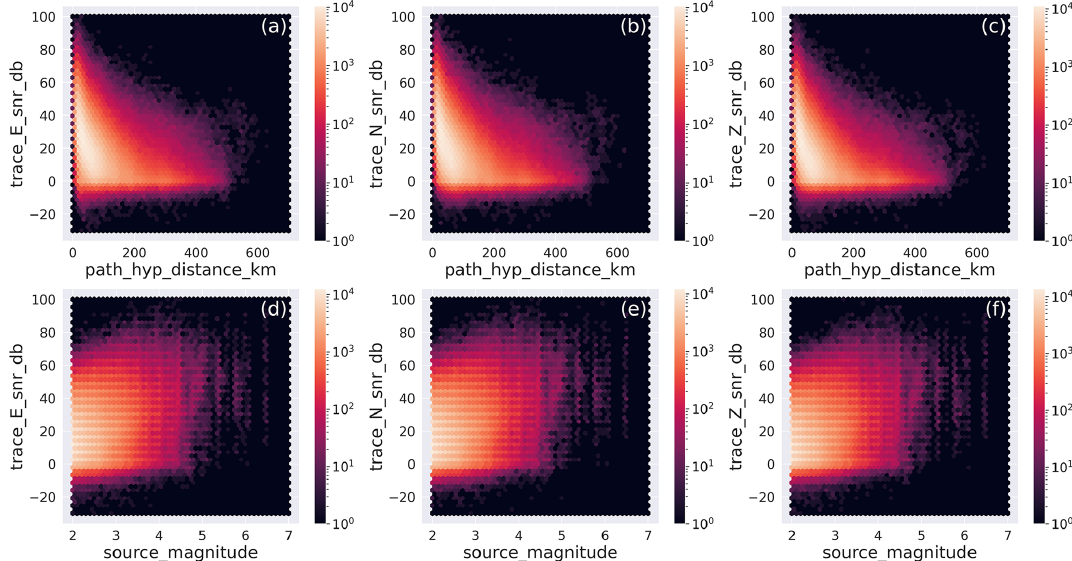
Figure 11. Hexbin representation of the distribution of the signal-to-noise ratio for the E , N , and Z components of the earthquake dataset as function of hypocentral distance and magnitude. The metadata names listed in Table 2 are used as labels for the specific metadata being represented.